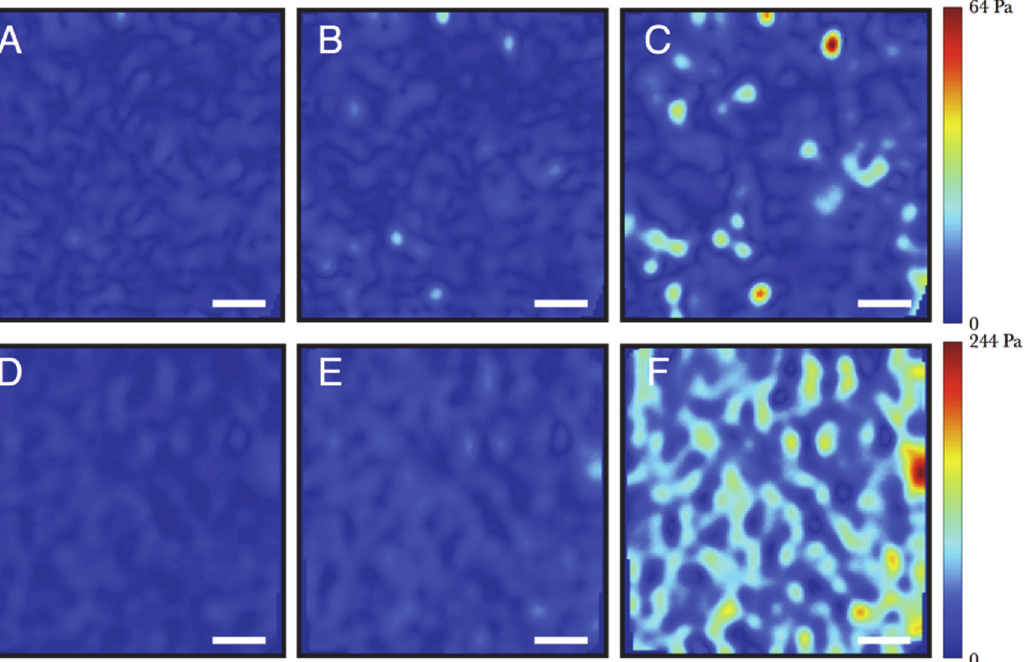
! k at the interface for relatively sparse k